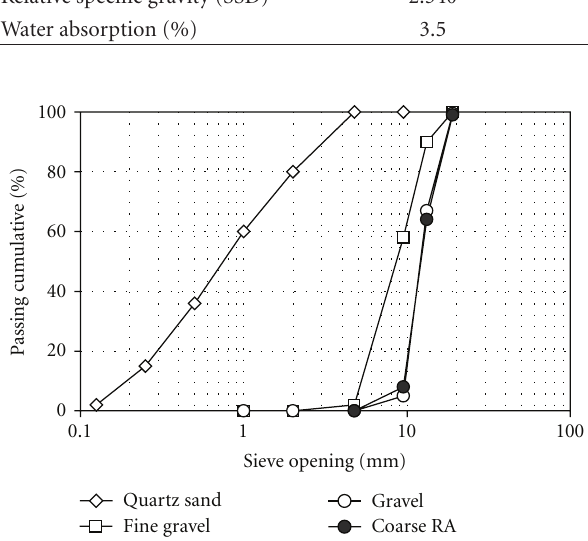
Figure 1: Grain size distribution curves of the aggregate fractions.